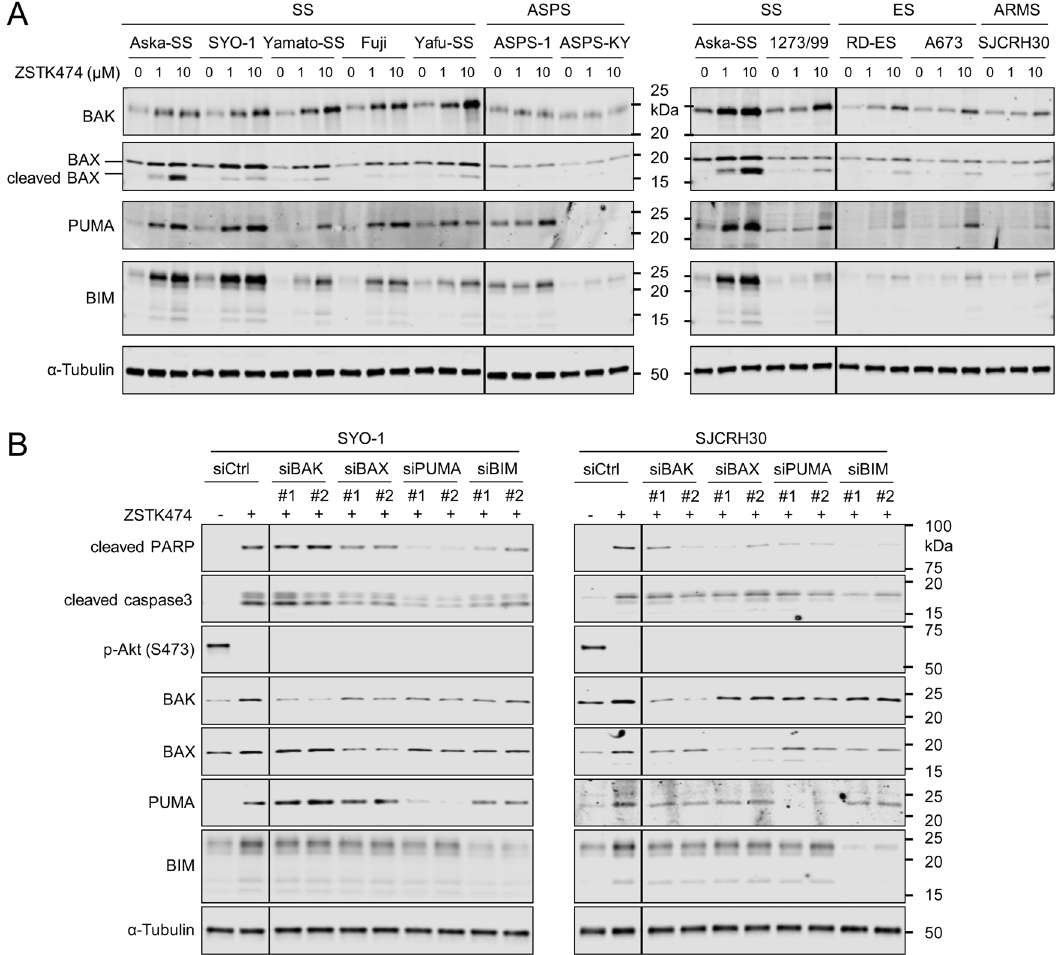
Fig. 4 An increase in the expression of BIM and PUMA and the subsequent activation of BAK/BAX contribute to the induction of apoptosis by a PI3K inhibitor. A Immunoblot analysis to examine the effect of the PI3K inhibitor ZSTK474 on the expression of proapoptotic BCL-2 family proteins including BAK, BAX, PUMA and BIM in the indicated TRS cell lines including SS, ES, ARMS and ASPS. TRS cells were treated with ZSTK474 at the indicated concentrations for 48 h. B Effect of siRNAs speci fi c to BAK, BAX, PUMA and BIM on the induction of apoptosis by ZSTK474. TRS cells transfected with siRNAs were incubated with or without ZSTK474 at 10 μ M for 24 h. Lysed samples were immunoblotted to detect BAK, BAX, PUMA, BIM, phosphorylated Akt at Ser473, cleavage of PARP, activation of caspase3 and α -Tubulin. These experiments were performed independently at least two times with similar